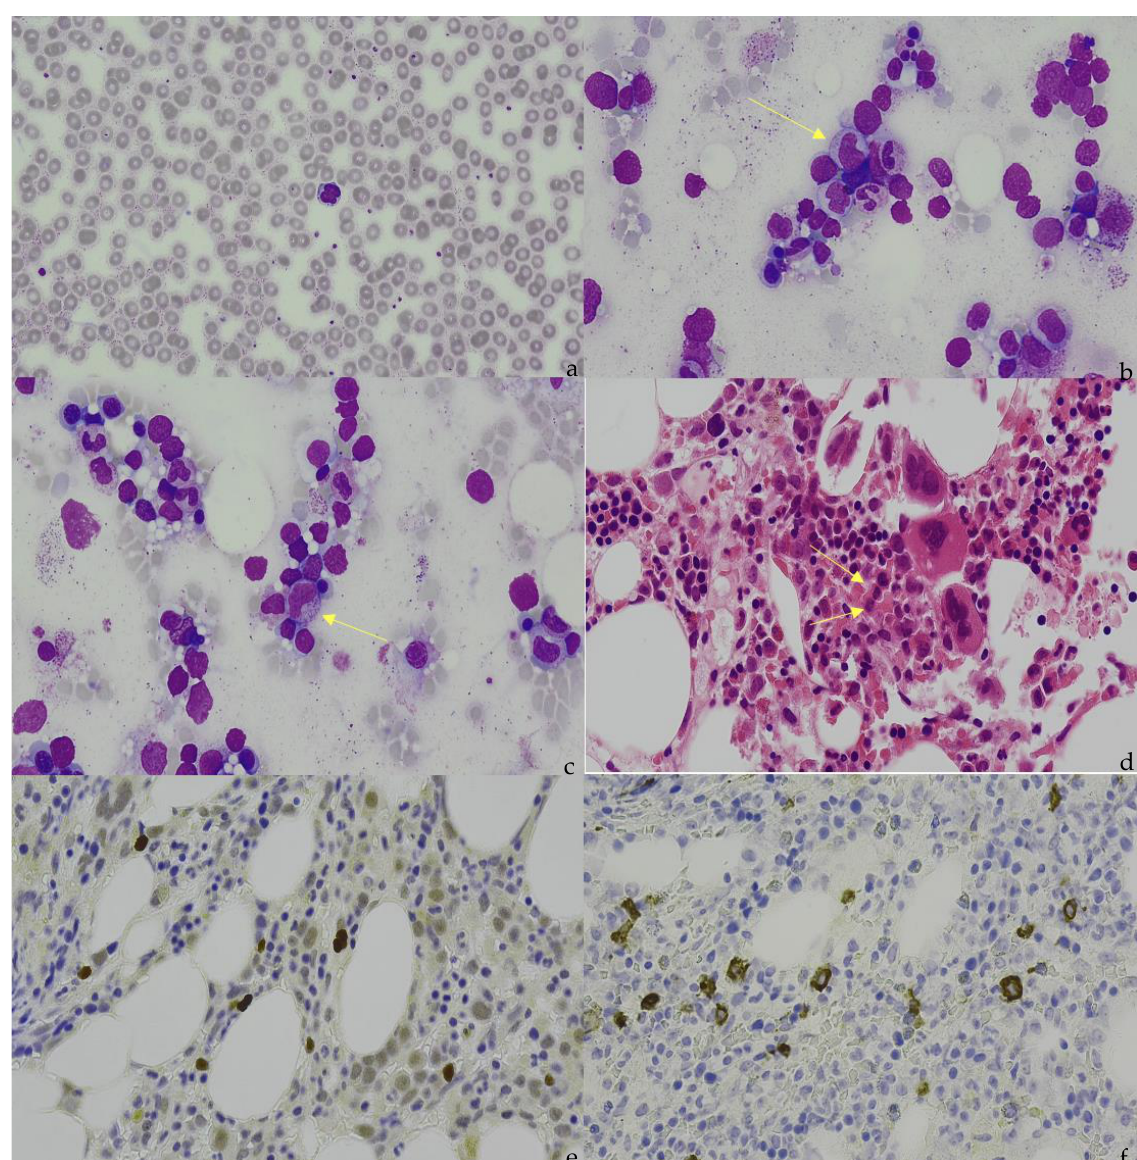
Figure 1. ( a ) Peripheral blood appearance of extranodal NK/T-cell lymphoma (ENKTCL). The ENKTCL cells are of medium size with irregular nuclei, slightly dispersed chromatin, inconspicuous nucleolus, and moderate amounts of granulated cytoplasm. ( b ) (Marrow aspirate), ( c ) (Marrow aspirate), and ( d ) (Trephine). Arrows indicate the infiltration of ENKTCL into the bone marrow. The ENKTCL cells have similar appearance as described in the peripheral blood smear. Trilineage hematopoiesis is represented in this patient. ( e ). Immunohistochemical staining shows that the ENKTCL is positive for CD56. ( f ). In situ hybridization (ISH) staining shows that ENKTCL is positive for EBV-encoded RNAs.